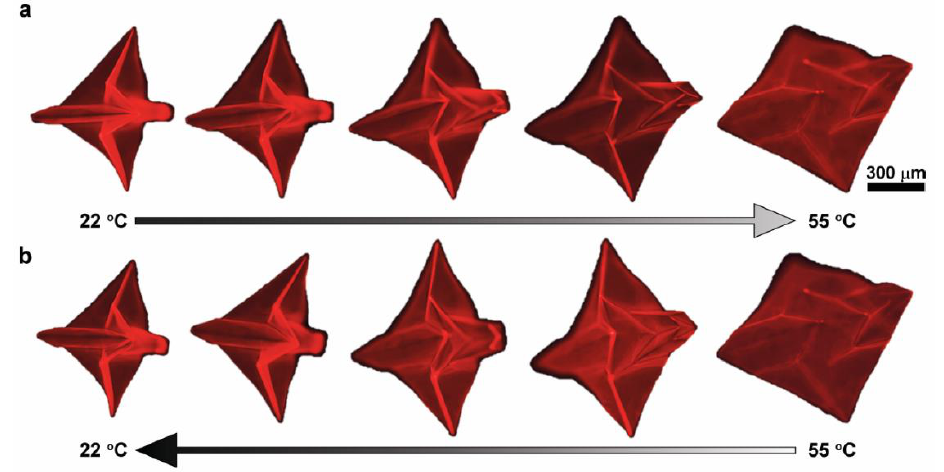
Figure 4. Thermally actuated origami folding: ( a ) cooling, deswelling and flattening, ( b ) heating, swelling and folding [58].